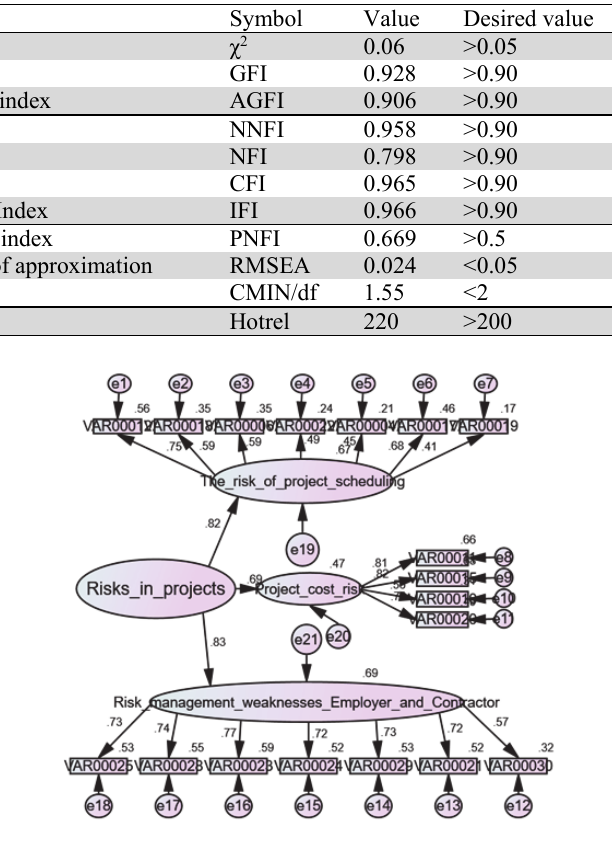
The results of statistical observations